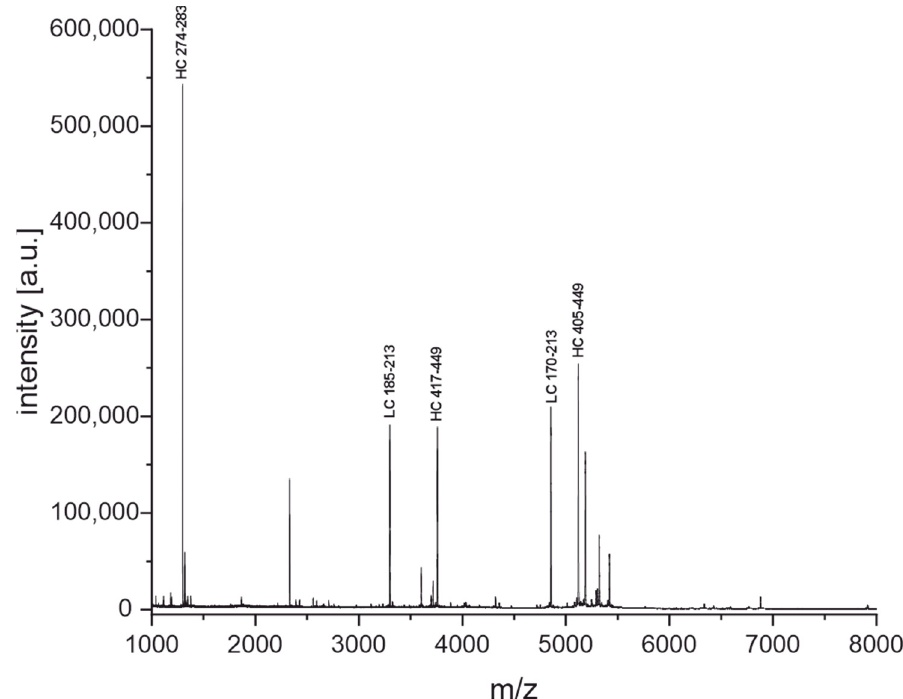
Figure 6. MALDI-TOF fingerprint spectrum of NIST-mAb 8671 after 30 min of incubation with diluted sulfuric acid and TCEP at 99 °C. The five most intense peptide peaks are assigned to the sequence of the NIST antibody in the spectrum (HC heavy chain, LC light chain). Sequence assignment was possible for most peaks, including variable and hypervariable regions (see Figure S2). The sequence coverage was around 61%.